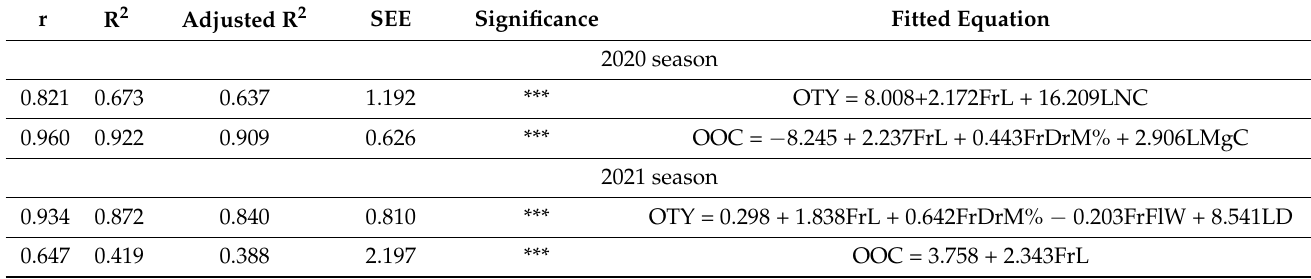
Table 9. Proportional contribution in predicting olive tree yield (TOY, kg) and olive oil content (OOC, %) using stepwise multiple linear regression for multi-stressed olive trees fertilized by mono- ammonium phosphate (MAP) and urea phosphate (UP) in three levels in comparison with the recommended granular calcium super phosphate (GCSP) level in 2020 and 2021 seasons.